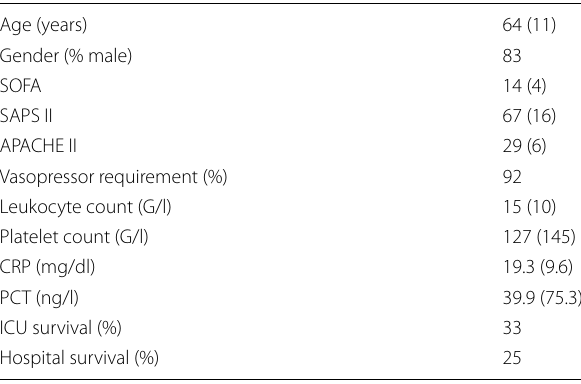
Table 1 Patient characteristics